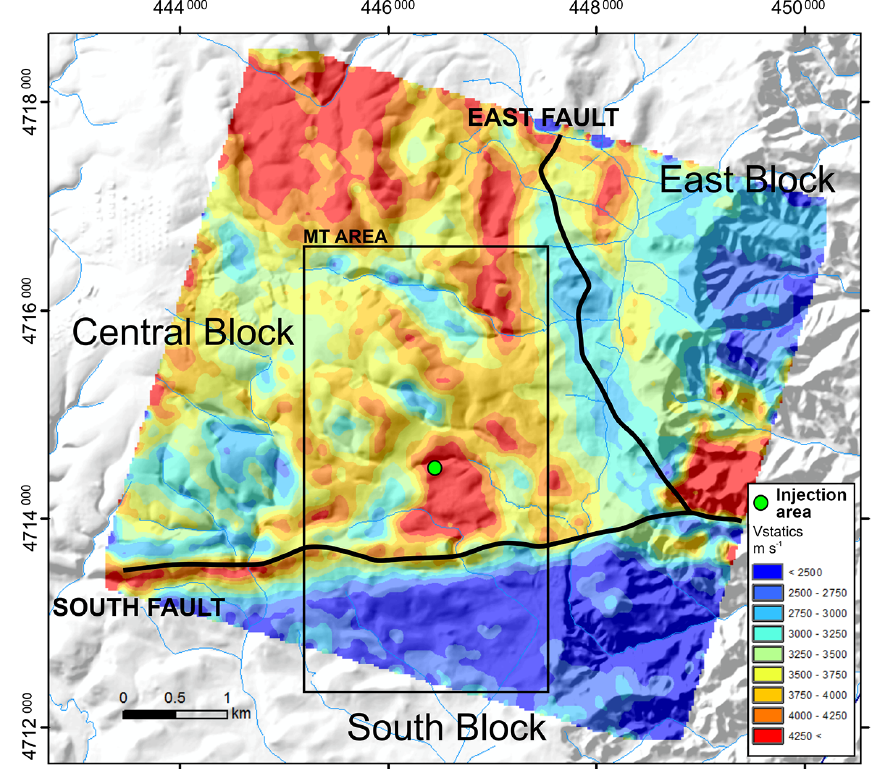
Figure 9. Velocity model used in the static corrections calculations, with the area covered by the MT. The position of the East and South faults, extracted from the seismic data, divides the study area in the central, east, and south blocks. Note that the two faults do not outcrop in the study